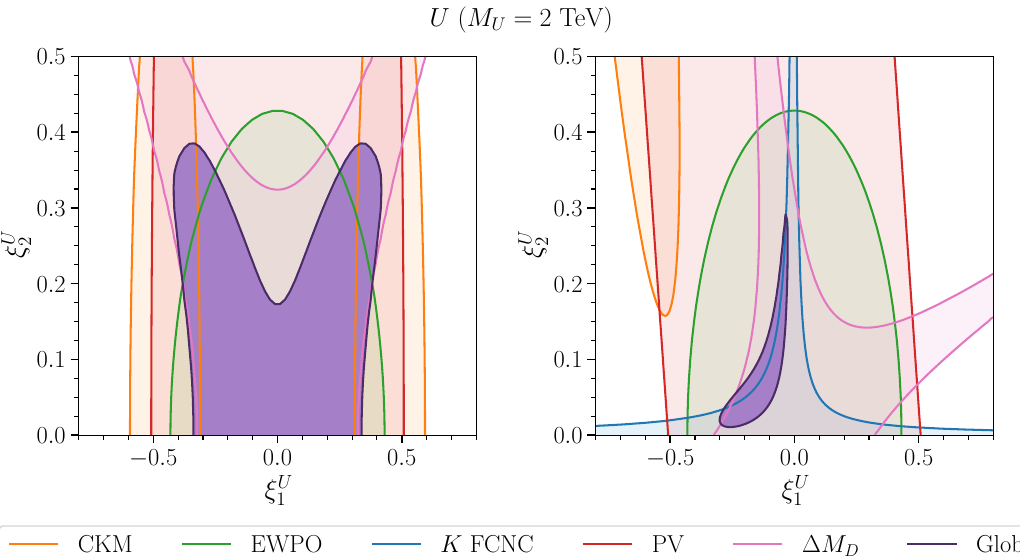
Figure 8 . Global fit to 1 st and 2 st generation couplings of the VLQ U . The left-hand side assumes multiple generations of VLQs, each only coupling to a single generation (i.e. effectively removing constraints from kaon physics), while on the right side this assumption is